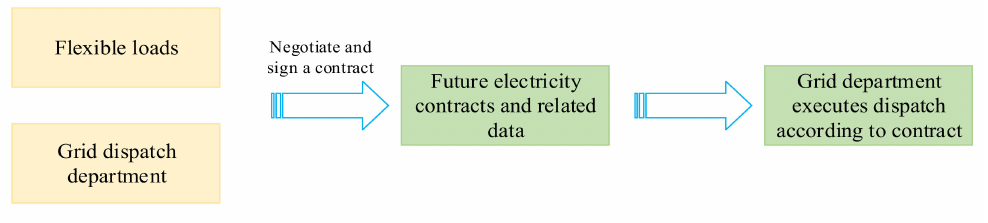
Figure 4. Real-time dispatching process of power grid considering flexible